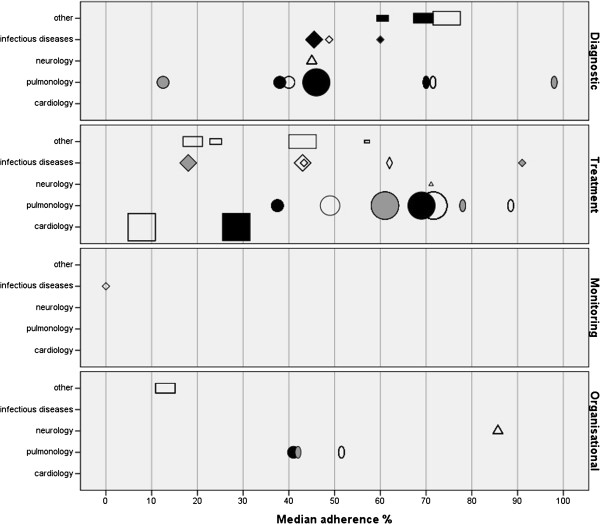
Adherence ED setting.